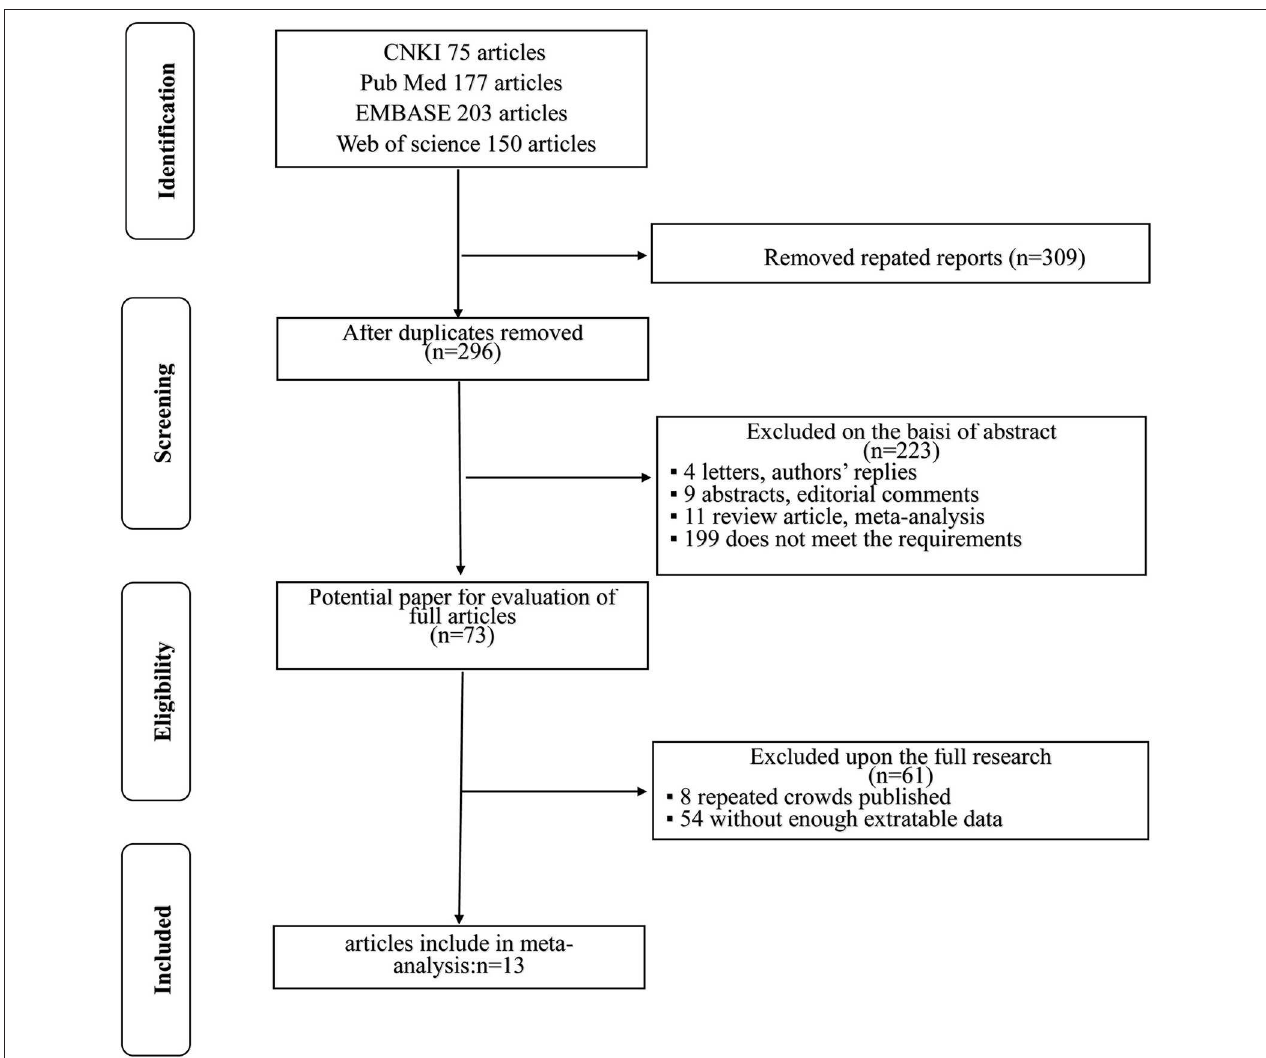
FIGURE 1 | Flow diagram of the study selection process in this